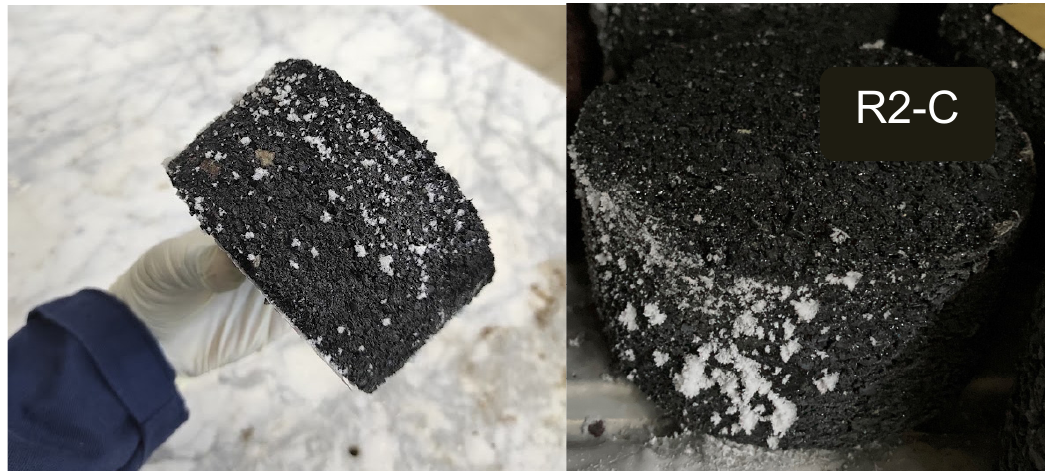
Figure 5. R2-C aspect after the 5th freezing cycle of the F–T cycles.